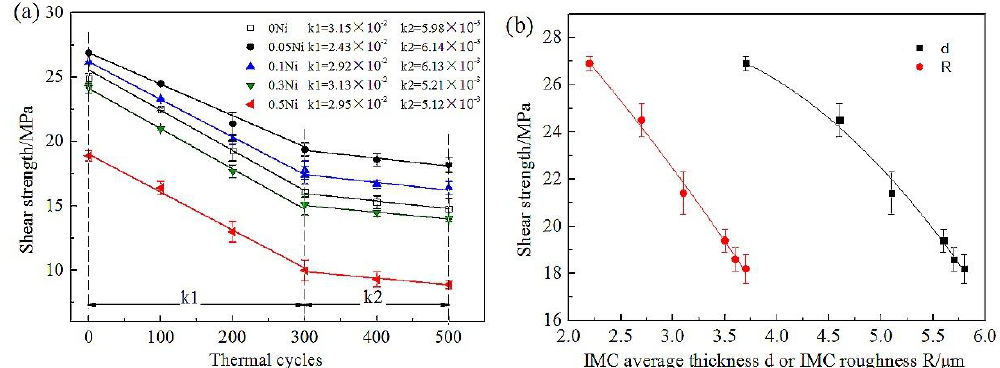
Figure 10. Relationship between shear strength and number of thermal cycles ( a ) and the IMC thickness